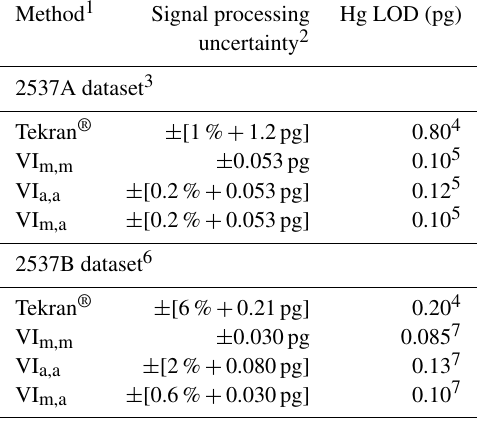
Table 2. Estimated signal processing uncertainties and Hg limits of detection (LODs) achieved with the Tekran ® peak integration method and my VI-based peak height determination methods as ap- plied to measurements made with Tekran ® 2537A and 2537B in-